Question: Does the figure show an increasing or a decreasing trend?
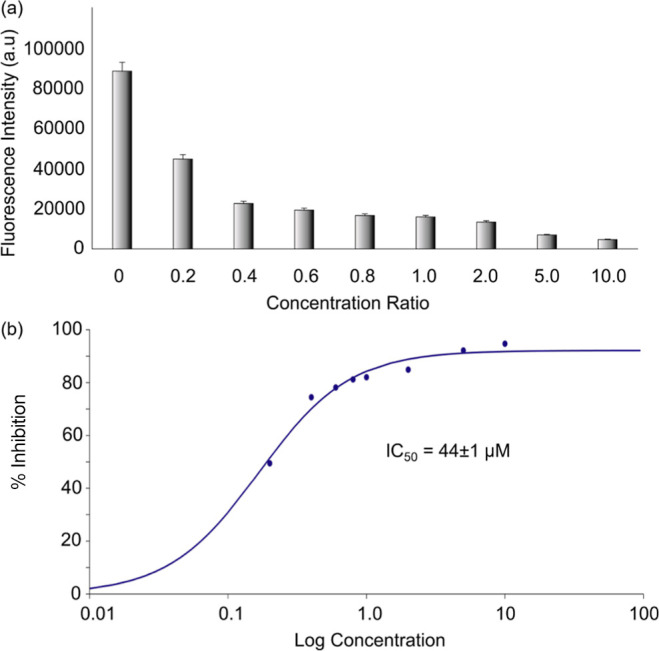
Answer: increasing